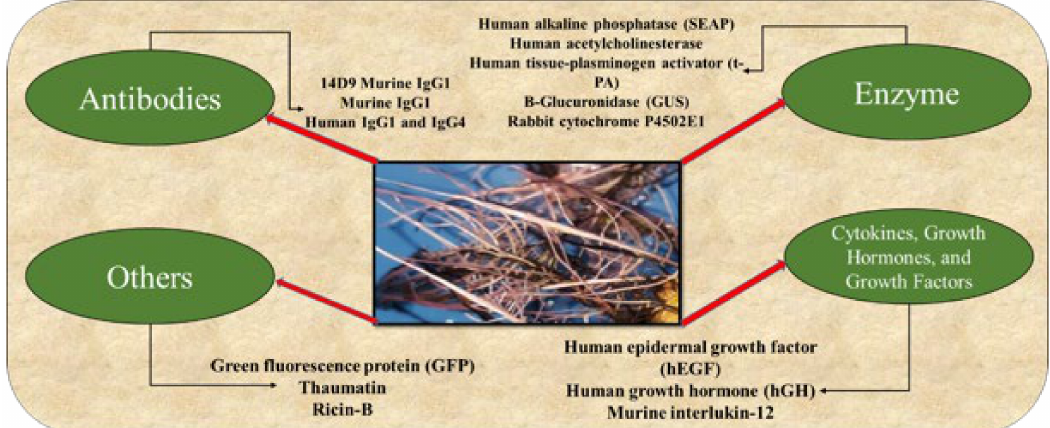
Figure 5. Hairy root cultures used to produce recombinant proteins. The final products of hairy root systems have been used to produce cytokines, vaccines, antibodies, enzymes, and other therapeutic proteins. These systems have various pros and cons, and these points should be considered when attempting to choose the best